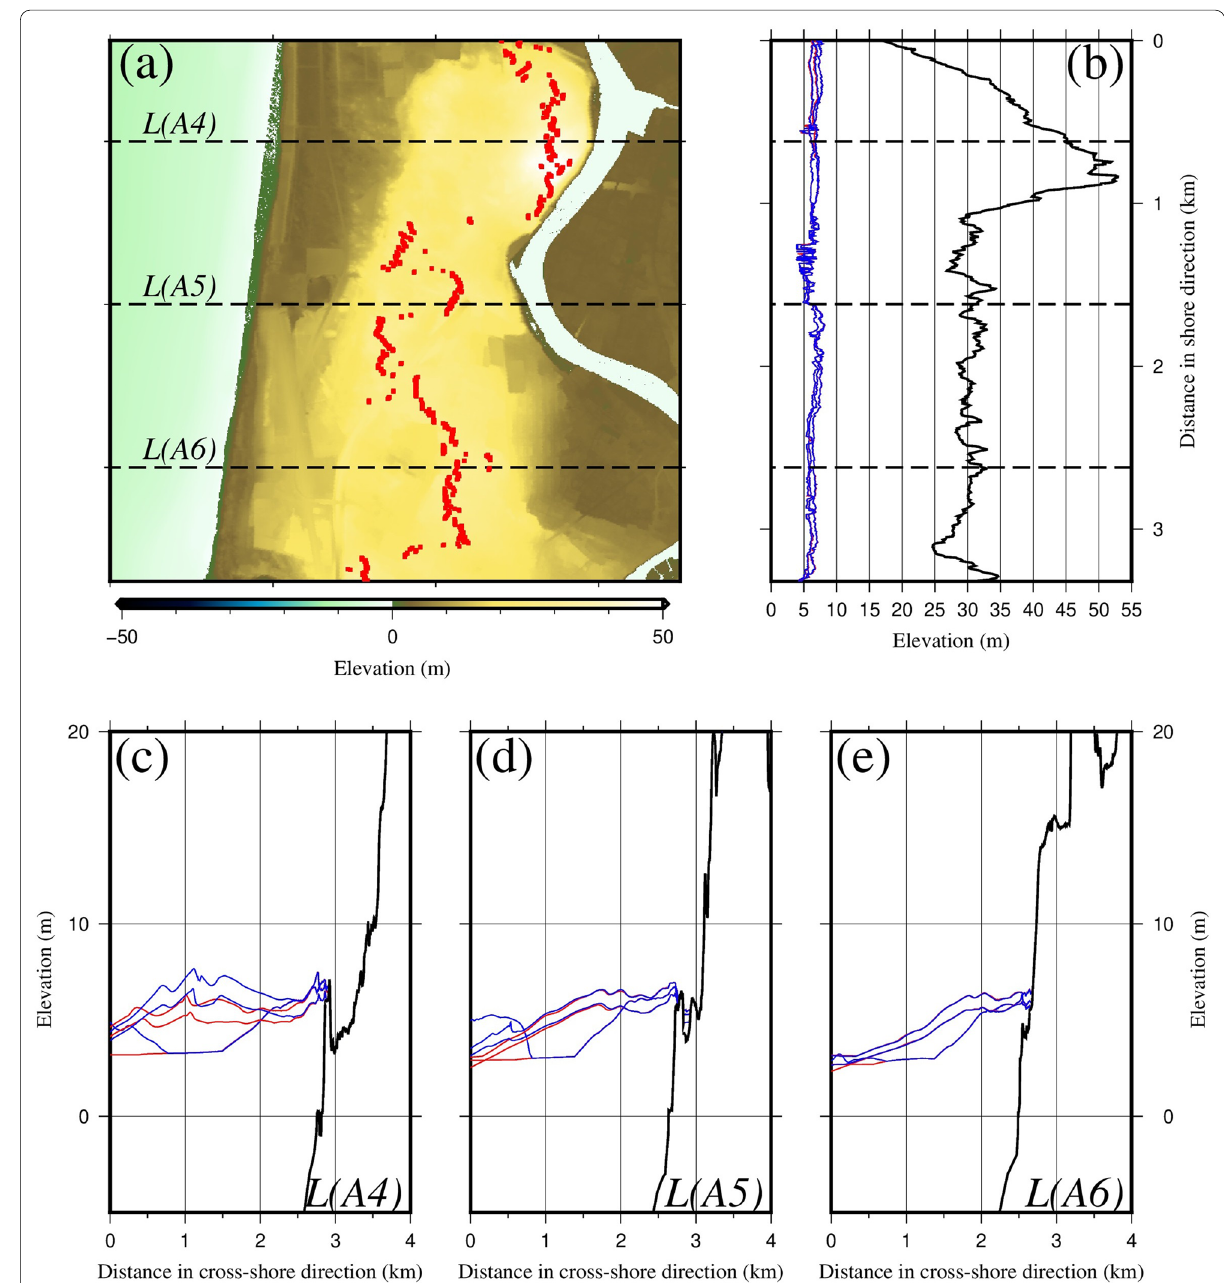
Fig. 4 Tsunami characteristics over the Akita dune. a Geometry and cross-sectional slices within the gray area specified in the top-right panel of Fig. 3, red circles indicate the highest locations along the cross-shore direction, and the thick interval was 1 km; b alongshore variations in the maximum run-up heights and the top elevation over the dune; c – e profiles of the dune and the maximum water surface elevation (inundation height) along the cross-sectional slices. Each line color in ( b – e ) indicates the dune profile (black) and the tsunamis in the F26, F30, and F31 source scenarios with the breakwaters (blue) and without